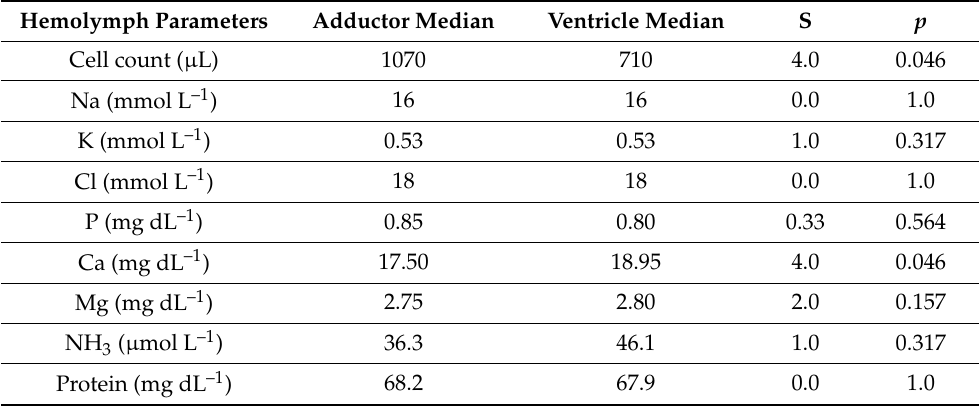
Table 1. Results of Friedman’s test of differences between harvest sites in a 2005 study of Elliptio complanata [10]. Median values for adductor muscle and ventricular fluids are presented, as well as Friedman’s S statistic and related p